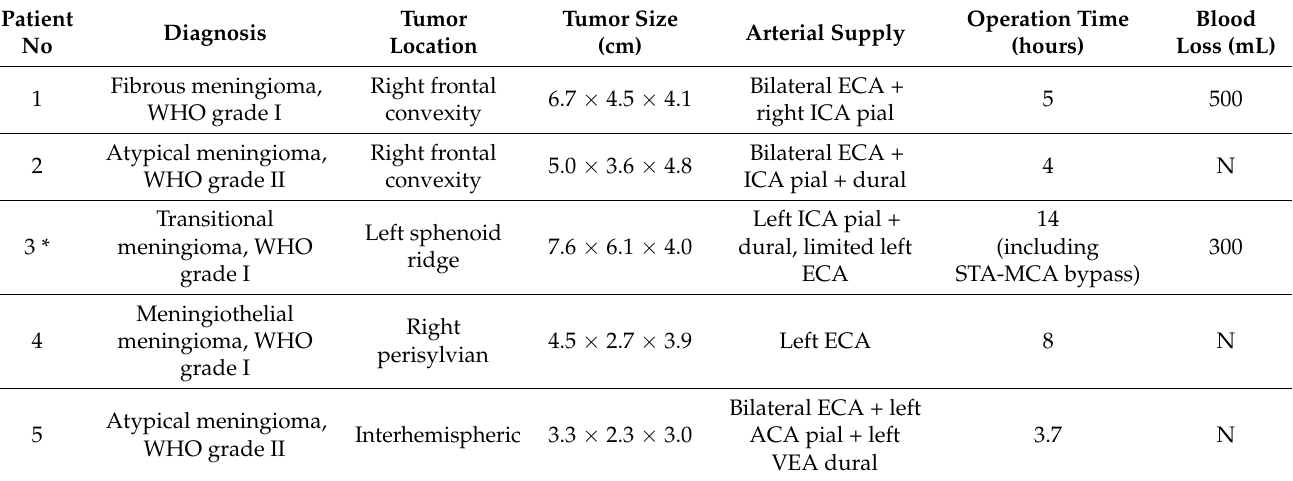
Table 1. This table summarizes the clinical characteristics of the tumor for the five